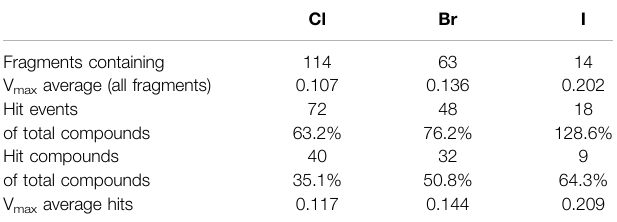
TABLE 3 | Comparison of relative hit rate by halogens type. Hit events summarize all four targets. Fragments with two halogens were counted only once. There are no fragments containing mixed types of